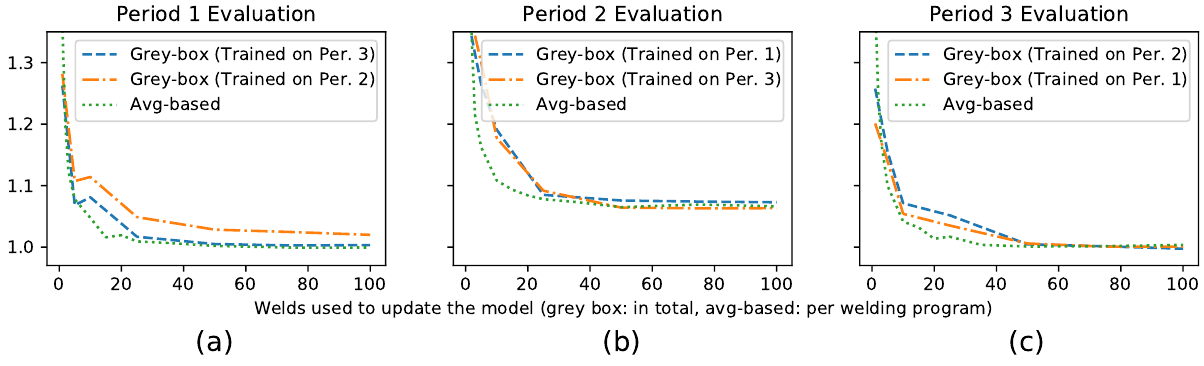
Figure 3. Evaluation results (averaged over 10 runs) where we trained the grey-box model on one maintenance period, e.g., P 1, updated the machine resistance parameter using a small number of welds from a different period, e.g., P 2, and predicted all remaining welds of P 2. The average- based model was trained using only P 2. ( a ) Evaluations of period 1 after training on period 2 or 3, ( b ) evaluations of period 2 after training on period 1 or 3, ( c ) evaluations of period 3 after training on period 1 or 2. We see how the prediction error converges to that of the average-based model, indicating that tweaking the machine resistance parameter is, in fact, sufficient to reuse the model across maintenance